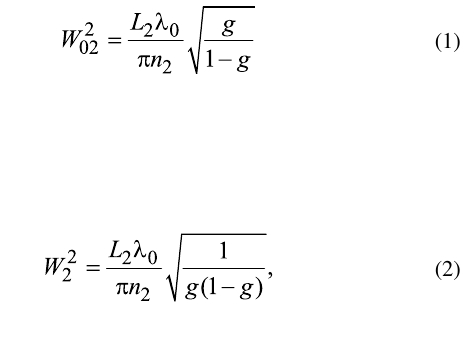
and W 2 corresponding to different pair of values ( R 2 , L 2 ) for